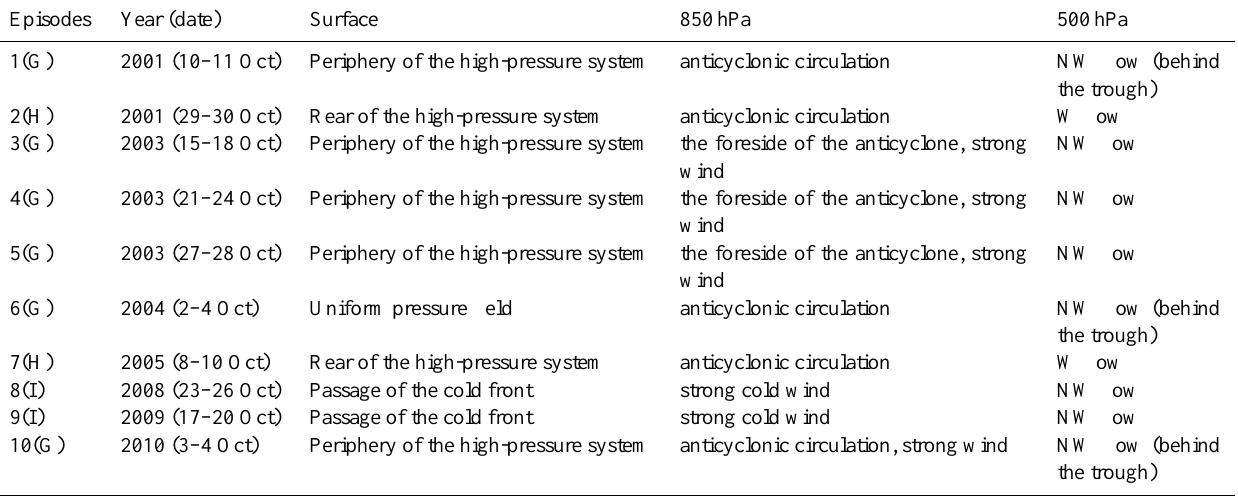
Table 2. As in Table 1 but for 10 clean